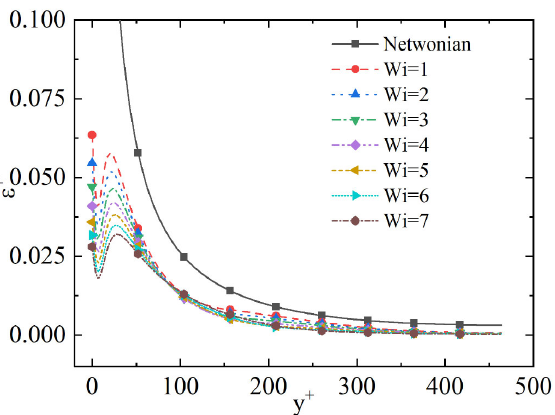
Figure 17. Dimensionless turbulent dissipation rate ( ε + ) of different Weissenberg numbers ( Wi ).